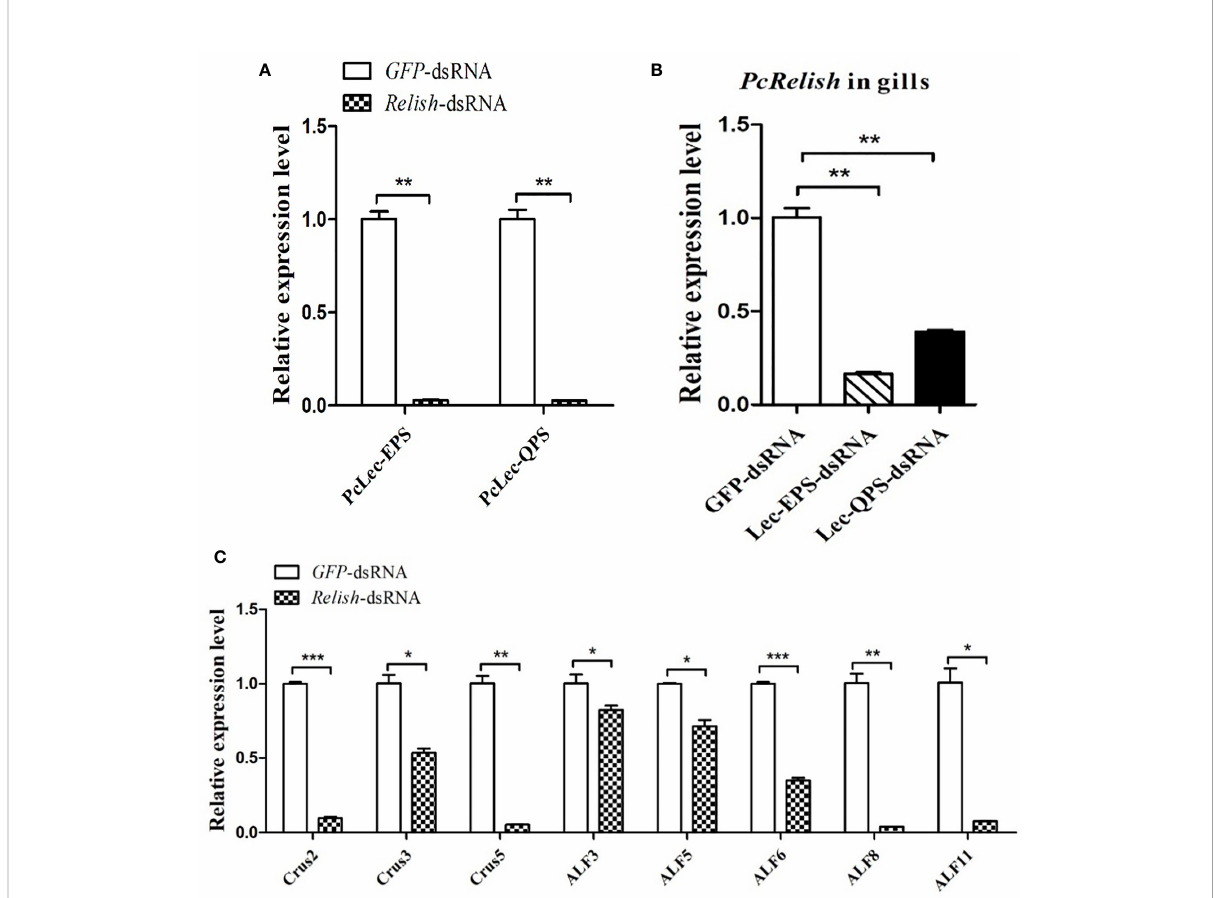
FIGURE 9 Analysis the regulatory relationship among CTLs ( PcLec-EPS and PcLec-QPS ), Relish, and AMPs in cray fi shes. (A) The expression levels of PcLec- EPS and PcLec-QPS in the gills at 48 h after Relish- dsRNA injection were detected by RT-qPCR. (B) Detection of the transcriptional level of Relish in the gills of Lec-EPS- dsRNA or Lec-QPS- dsRNA injected cray fi shes. (C) Detection of the expression levels of AMPs ( Crus2 , 3 , 5 and ALF3 , 5 , 6 , 8 , 11 ) in the gills of Relish- dsRNA injected cray fi shes. All data were normalized to GFP -dsRNA treated samples. Data are presented as mean ± SD, N=5. The asterisk indicated signi fi cant difference between experimental group and control group (* p < 0.05, ** p < 0.01, and *** p <